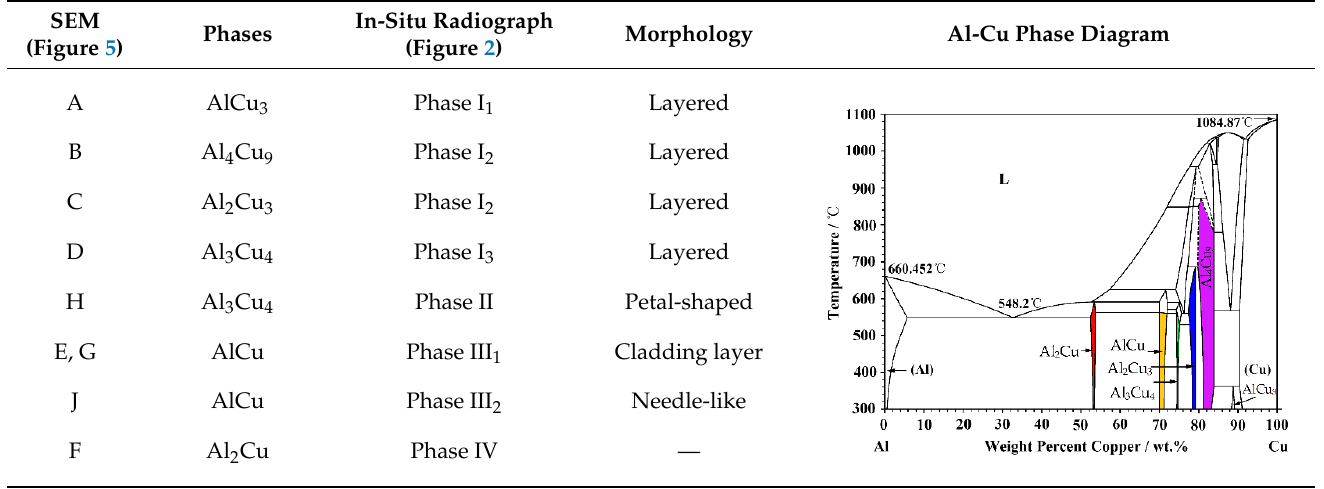
Figure 7. Sequence of in situ radiographs ( a – h) showing the growth of IMCs layers ( t 0 is assigned to the onset of colling).